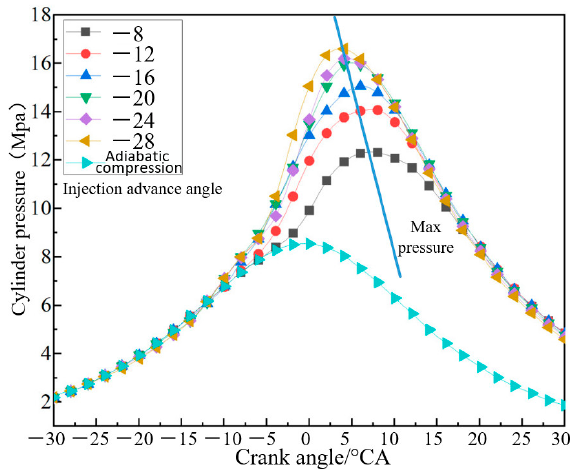
Figure 17. Variation of cylinder pressure with injection advance angle.